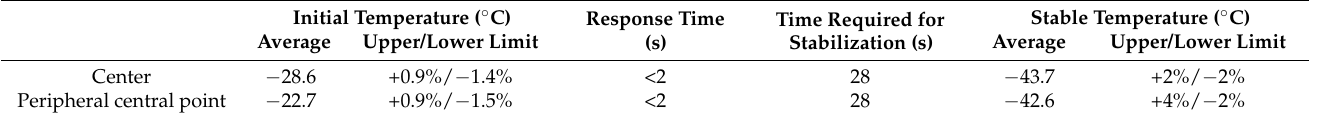
Table 5. Experimental data of three stages under the heat flux of 400 W/m 2 .